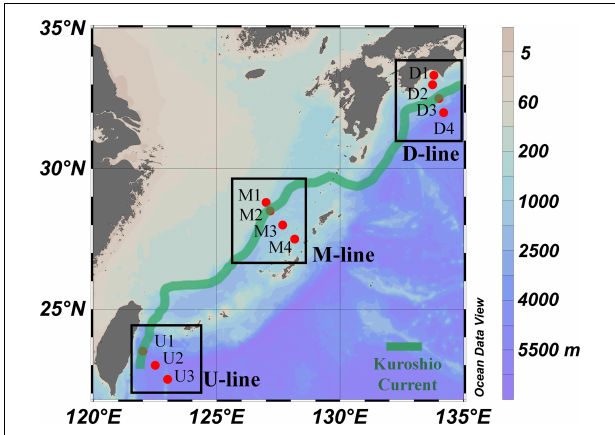
FIGURE 1 | Locations of sampling stations during the KH-15-4 cruise. The map and contour graphs were created using Ocean Data View (http://odv.awi.de/). Detailed information for each station is given in Table 1 . The location of the Kuroshio Current during the cruise was obtained from the Japan Coast Guard (see text) and is shown as a green line. Transect lines are also shown in black boxes.